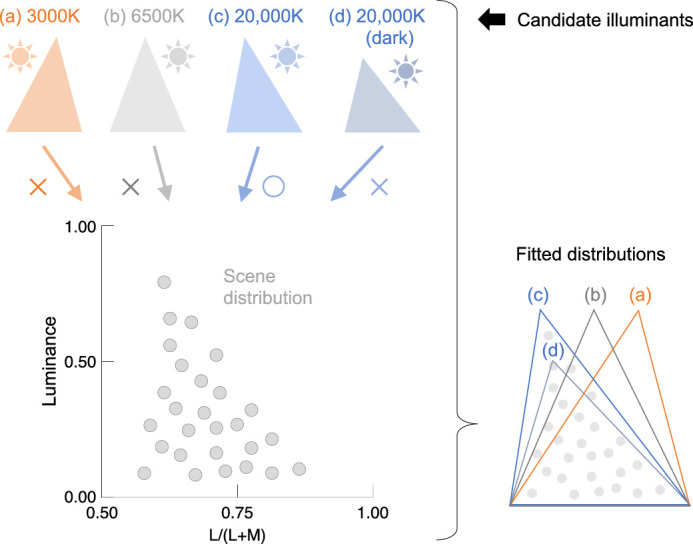
Schematic illustration of optimal color hypothesis. Our visual system internalizes optimal color distributions and selects the one that gives a most likely fit to the scene distribution. In this case, 20,000 K should be selected.